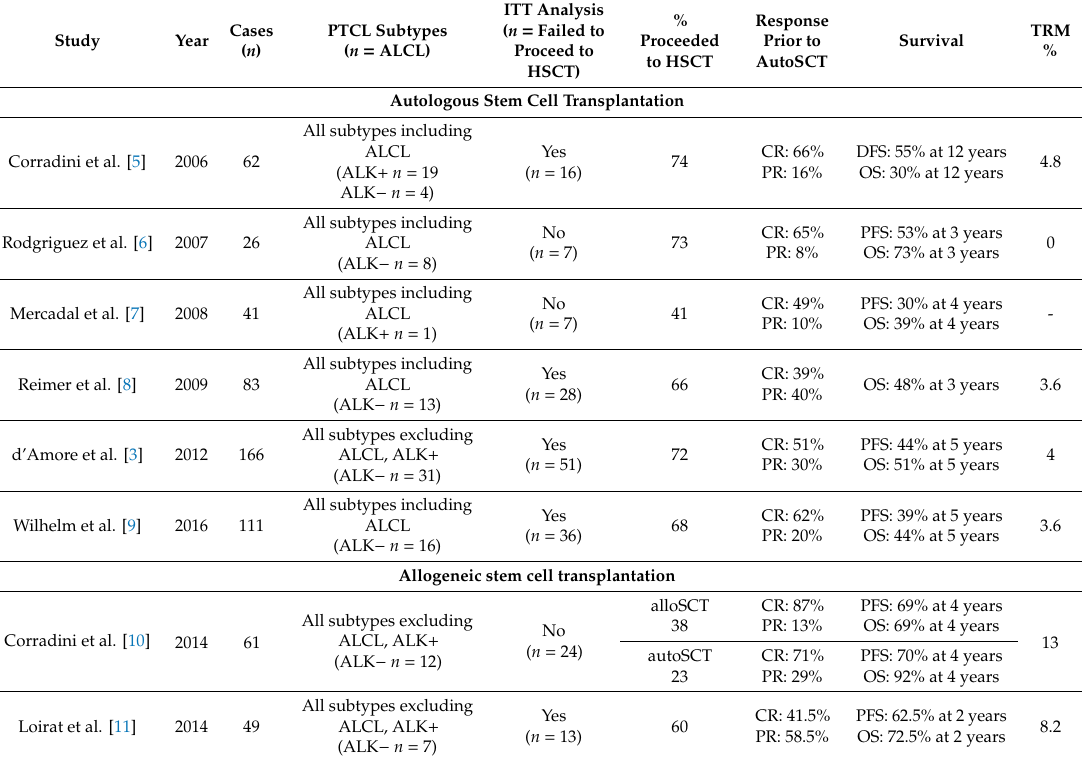
Table 2. Autologous and allogeneic stem cell transplantation in the frontline setting: prospective